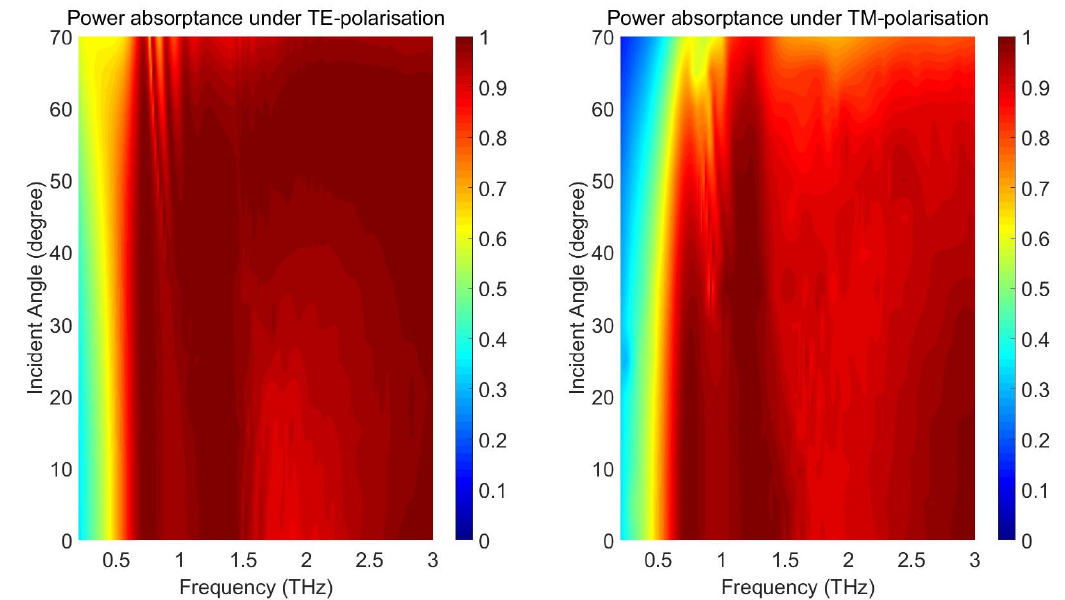
Figure 5. Simulated power absorptance as a function of frequency and incident